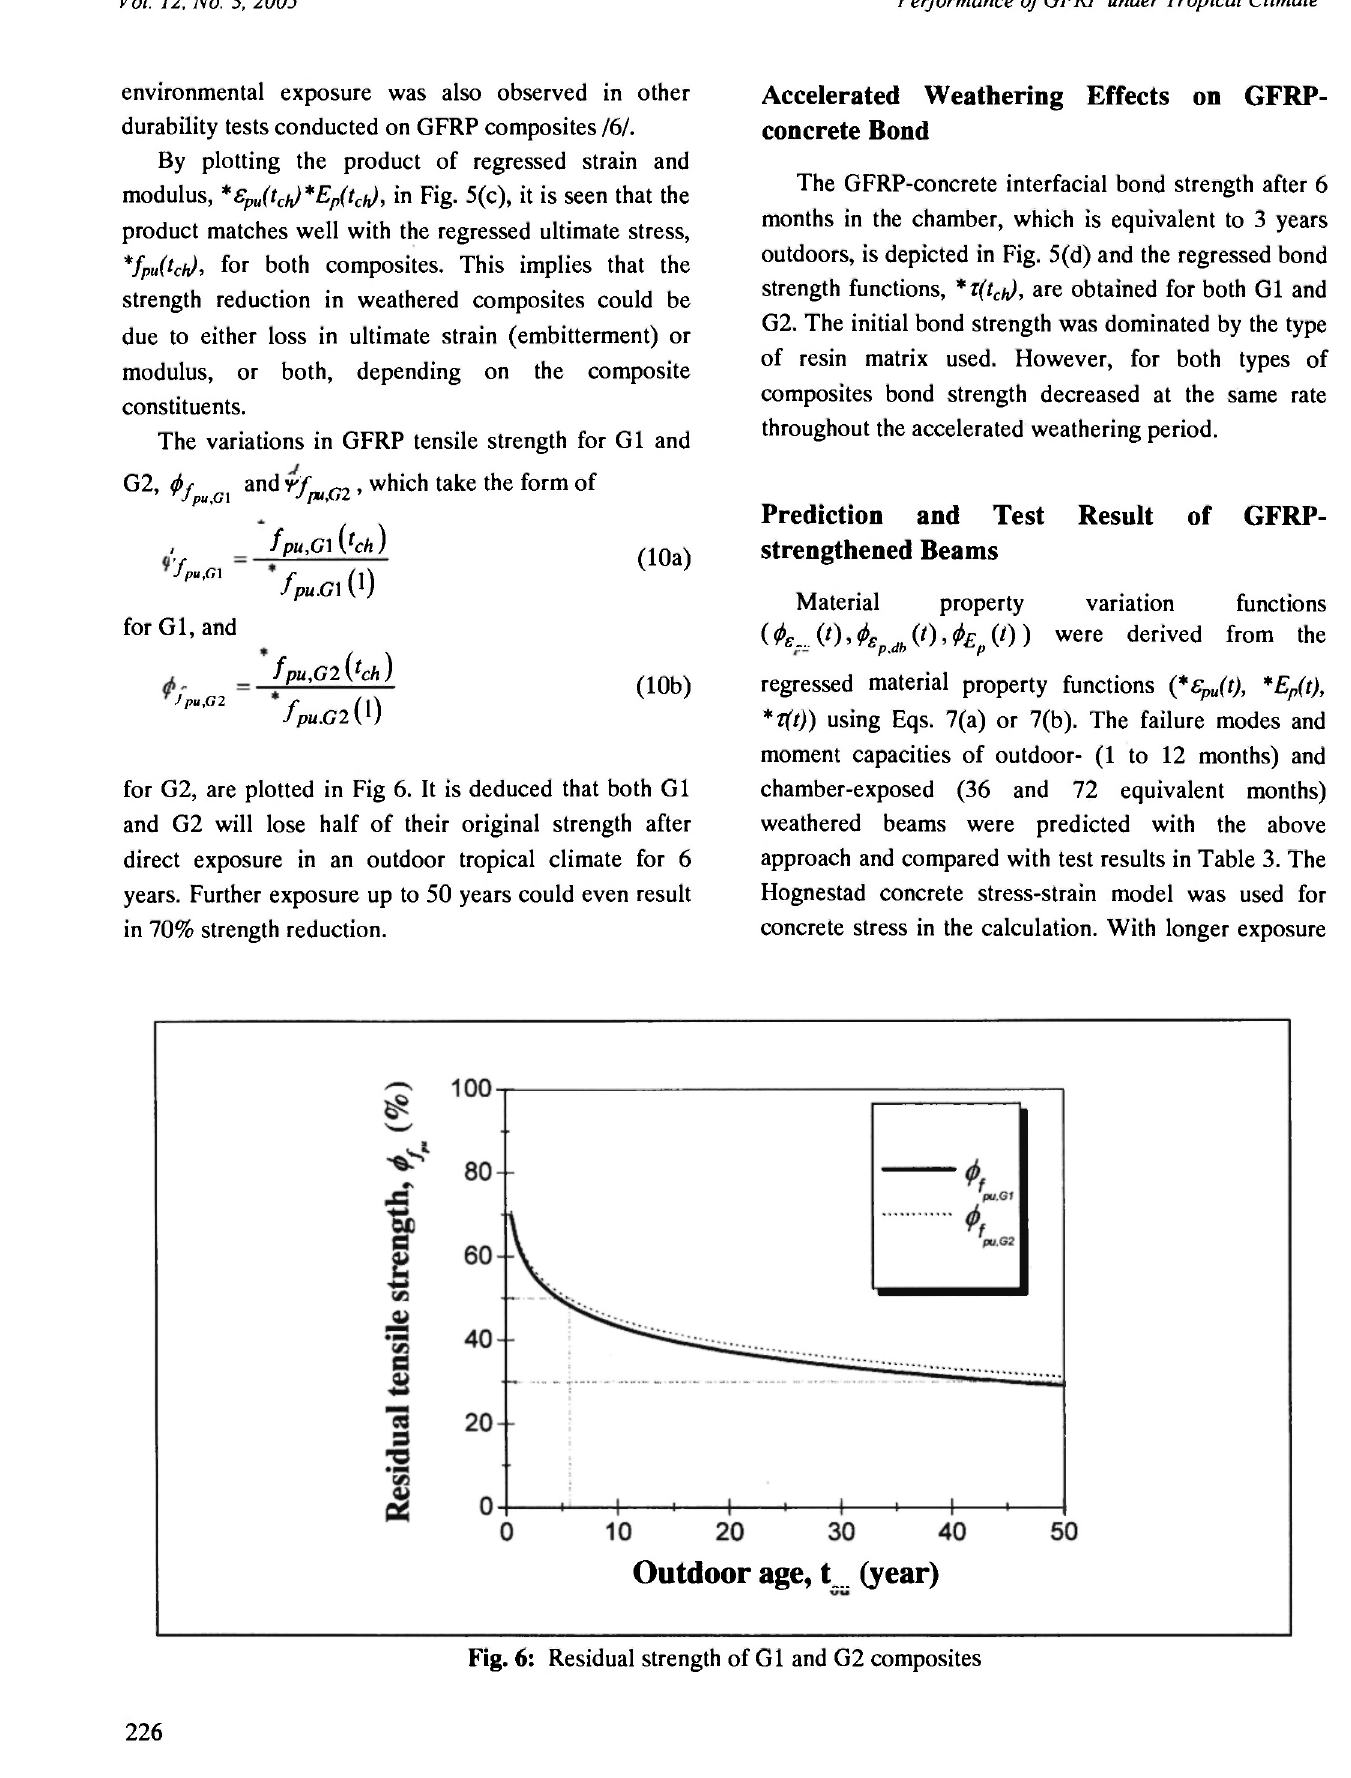
Fig. 6: Residual strength of Gl and G2